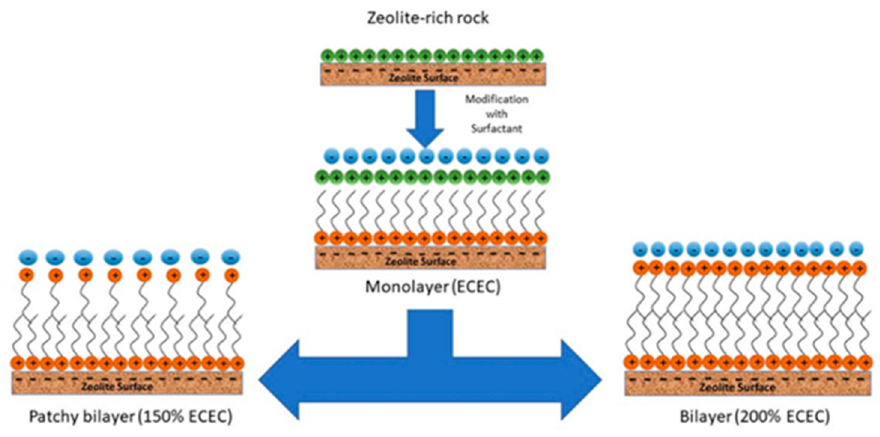
Figure 1. Scheme of the zeolite surface modification: monolayer formation by ion exchange and formation of the bilayer (patchy or complete) by interaction between the surfactant hydrophobic tails.